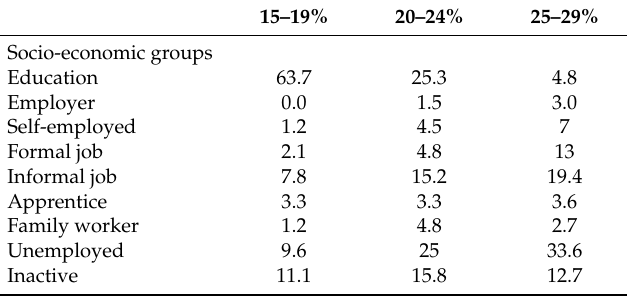
Table 7. Socio-economic groups by age, males (in percentages).